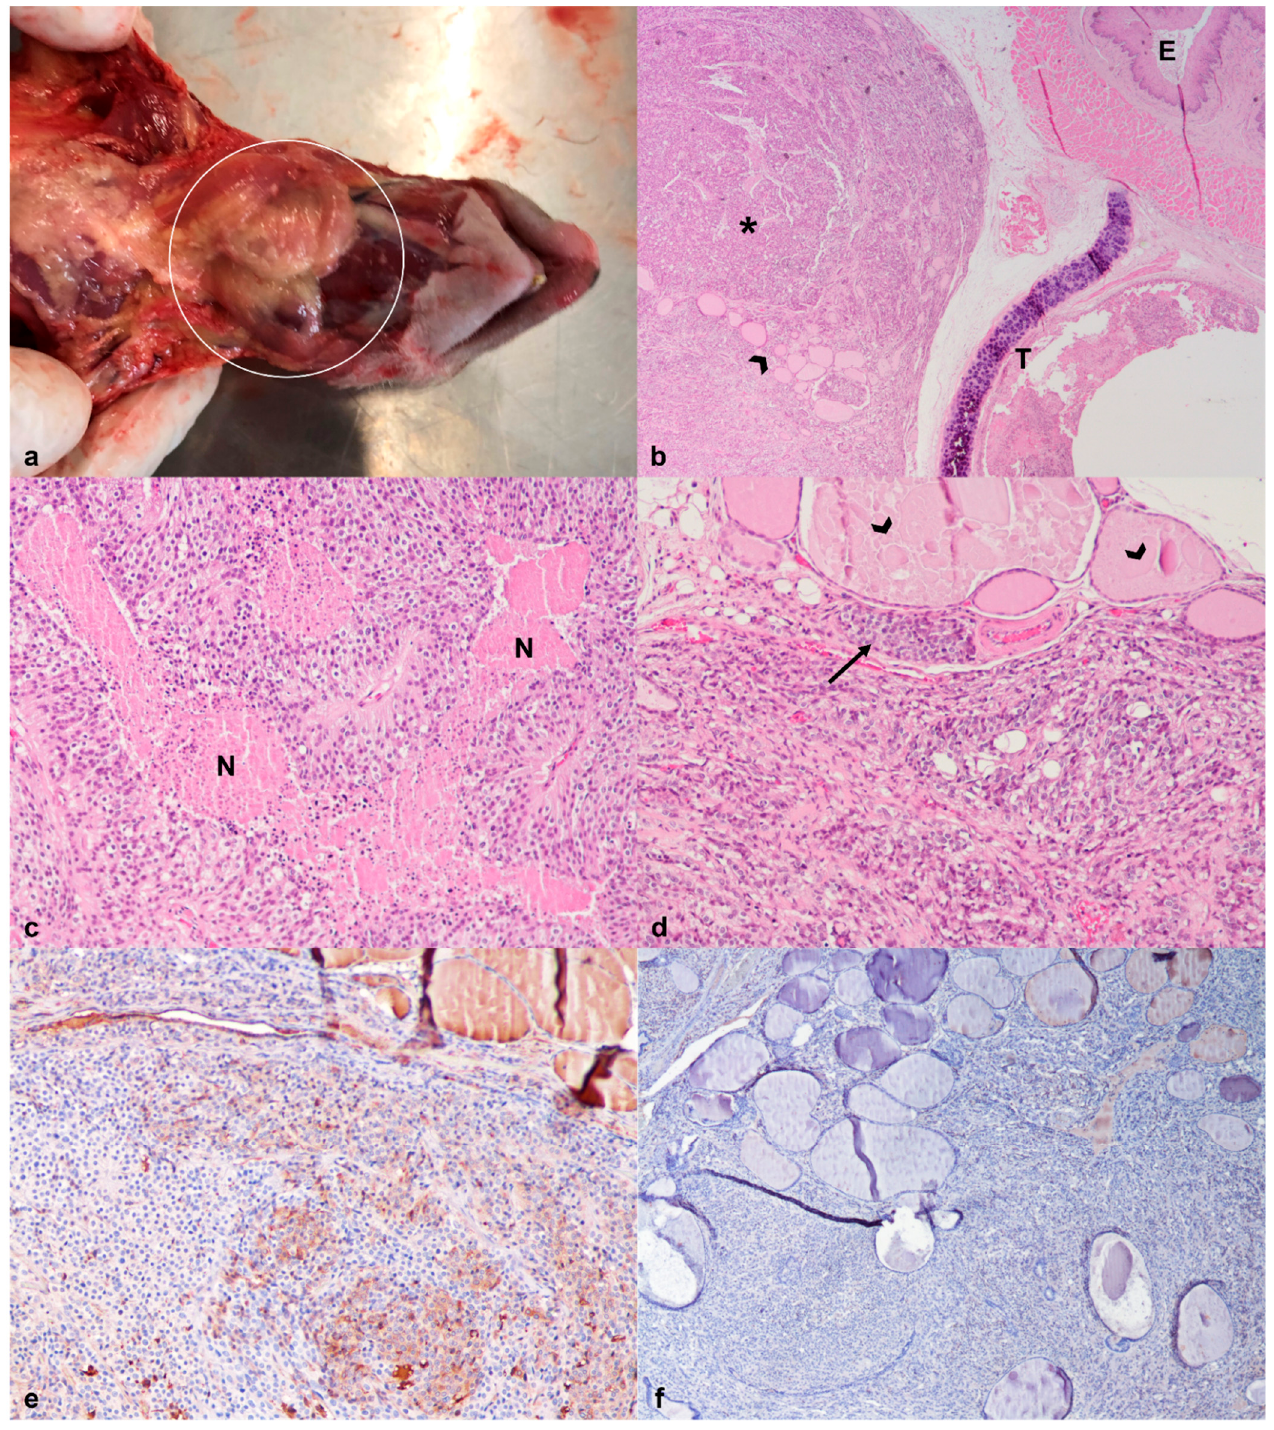
Figure 6. African pygmy hedgehog, thyroid gland. Case 2, Thyroid carcinoma. ( a ) Gross appearance of the bilobed cervical mass (circle); ( b ) The lesion is composed of neoplastic epithelial cells (*), forming solid structures separated by a fine fibrovascular stroma, and compressing the esophagus (E) and trachea (T). The remaining thyroid gland follicles are visible, particularly at the periphery of the neoplastic mass (arrowhead)( HE, 20 × ); ( c ) Multifocal areas of intratumoral necrosis (N; HE, 100 × ); ( d ) Note the foci of extracapsular tumor growth (arrow) and few remaining thyroid follicles (arrowhead; HE, 100 × ); ( e ) Considerable percentage of neoplastic cells present weak to moderate thyroglobulin-immunopositivity (100 × ); ( f ) Low percentage of neoplastic cells present weak immunoreactivity to synaptophysin (100 ×